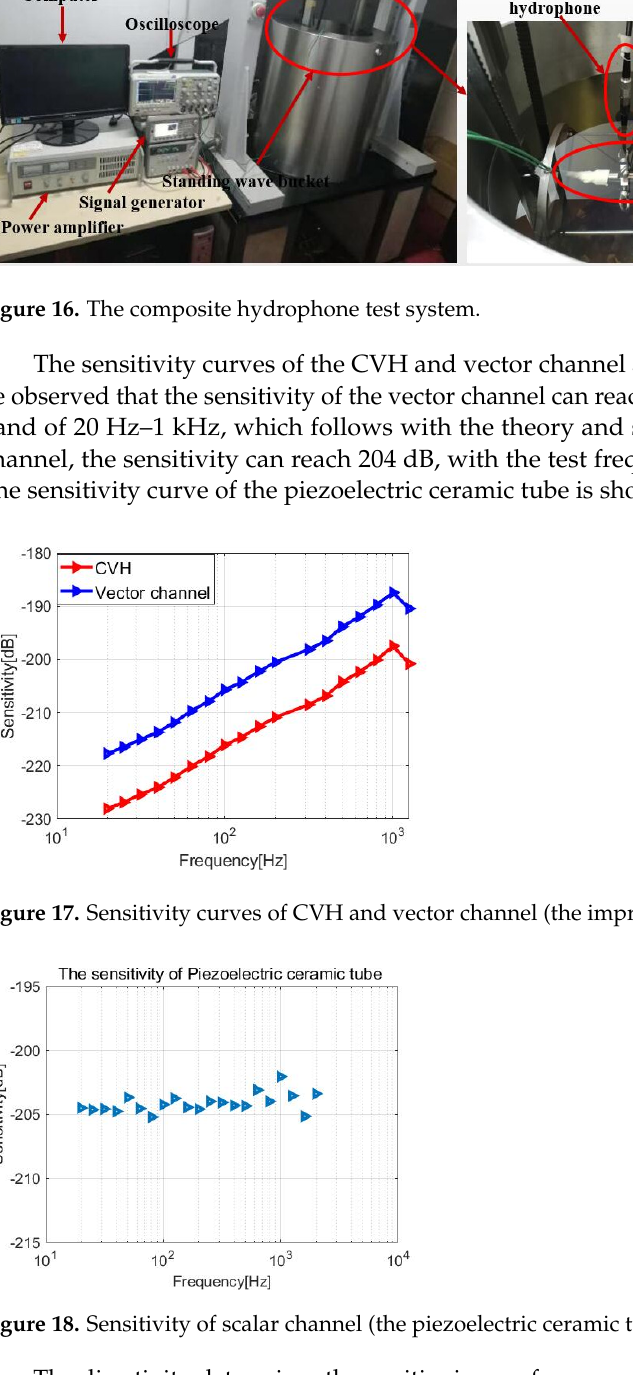
Figure 19. Directivity of composite hydrophone. ( a ) Vector channel at 500 Hz, ( b ) scalar channel.